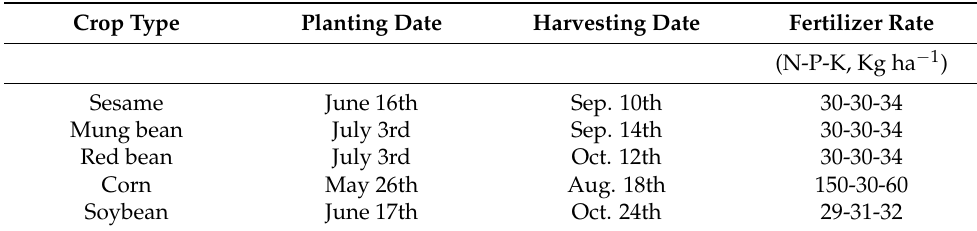
Table 2. Planting dates, harvesting dates, and fertilizer rates of cropping management for all five grain crops used in this